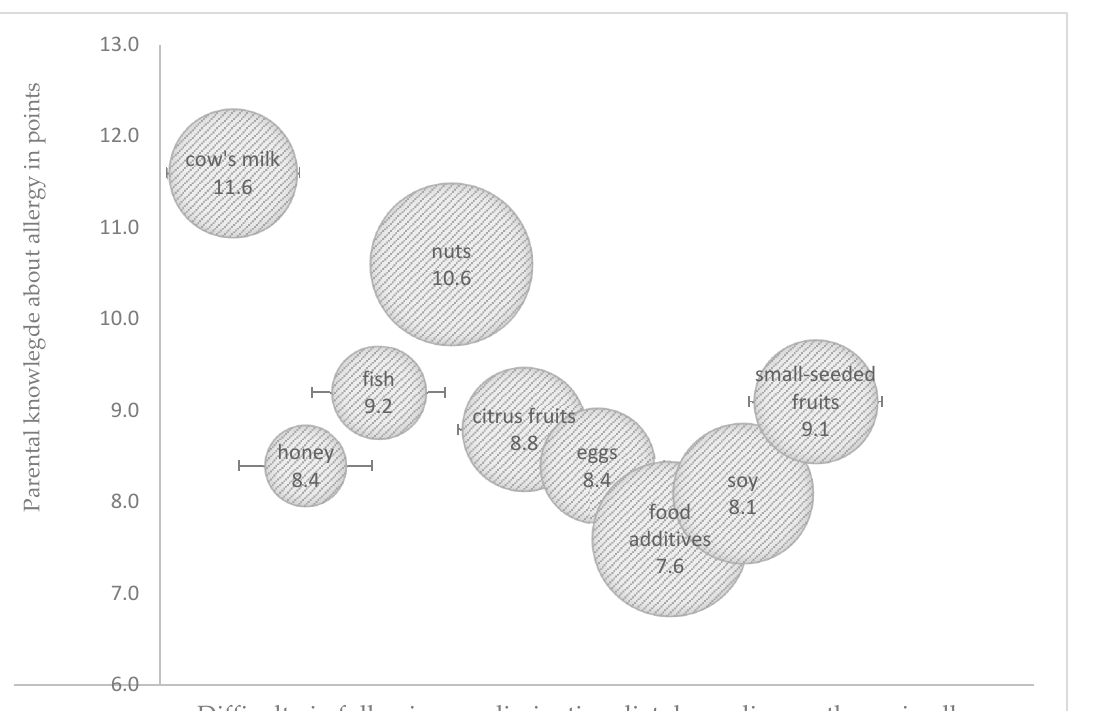
Figure 2. Main allergen and allergy to many food items. Food allergies were most commonly triggered by cow’s ‐ milk proteins (43.8%), chicken ‐ egg whites (27.6%), soy (21.9%), and fruit with small seeds (20.9%), and they were least frequently triggered by celery (5.7%) and fish (5.7%). Allergies to cow’s ‐ milk proteins and fruit with small seeds (e.g., blueberries, raspberries, black currants, gooseberries, or blackberries) were more prevalent in 3 ‐ to 4 ‐ year ‐ olds (OR 1.57; 95%CI 1.19–1.94, p < 0.05), whereas allergies to fish and citrus fruit (e.g., lemons, oranges, mandarins, or grapefruit) were more frequently noted in older children (OR 1.42; 95%CI 1.20–1.67, p < 0.05). The prevalence of allergies to other foods was not clearly correlated with age. Allergy type and the number of allergens affected the quality of the diet and dietary adherence. The odds ratios (95% confidence interval) of the relationships between the number of